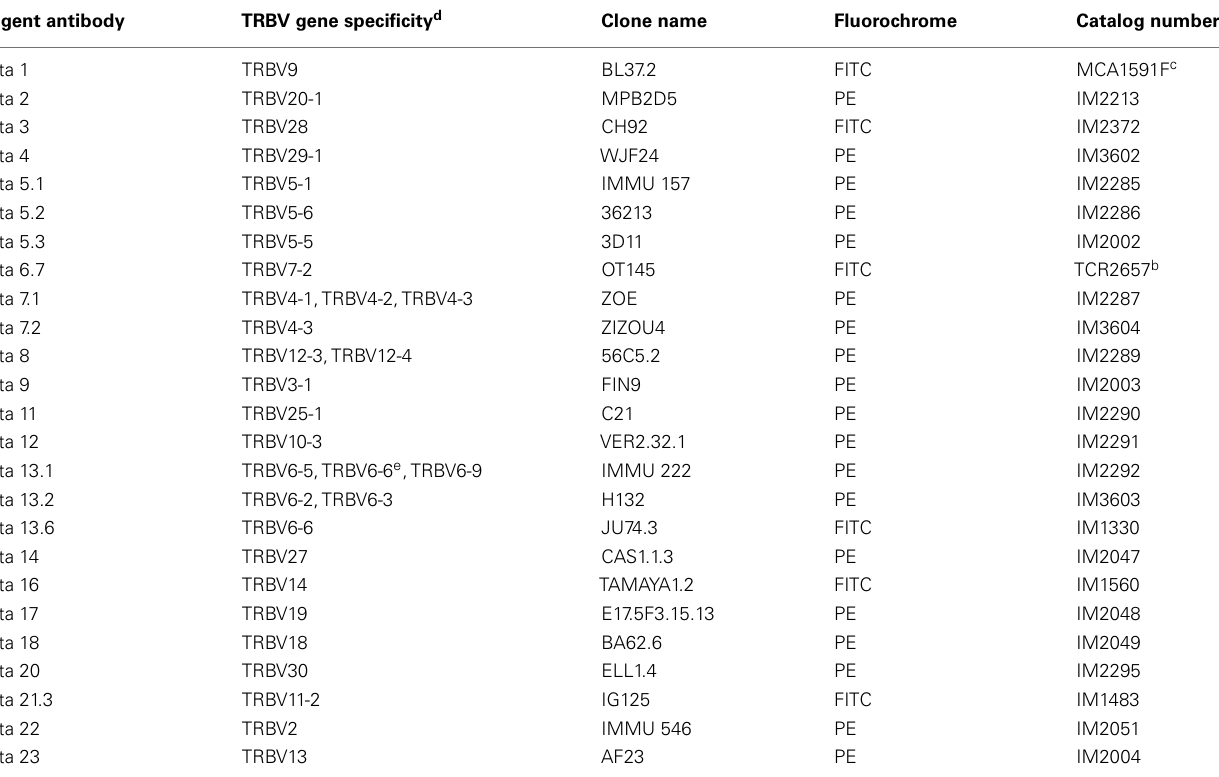
TableA1 | Monoclonal antibody characteristics.